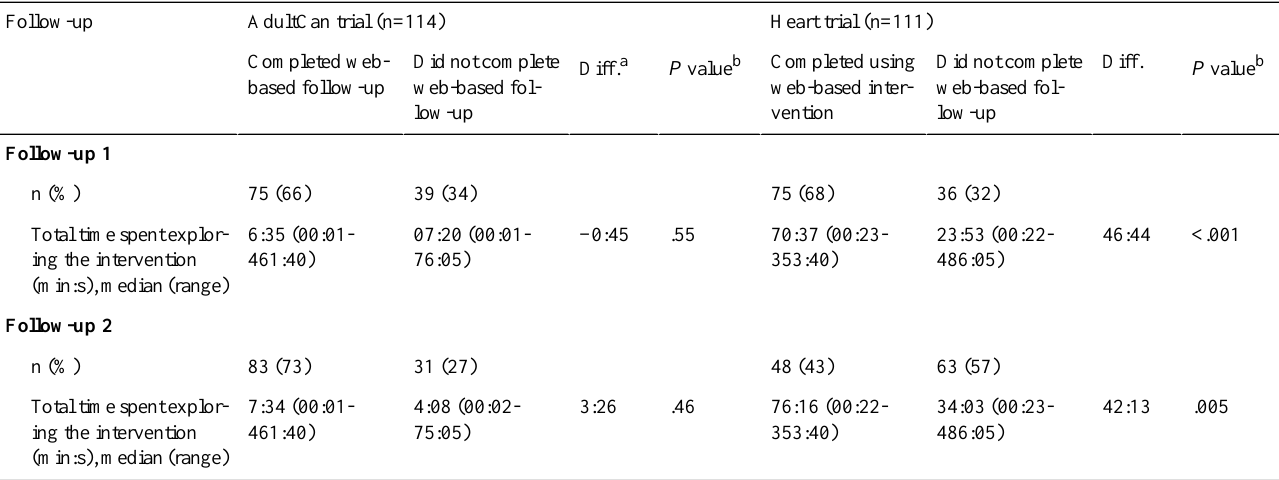
Table 6. Total time exploring the intervention during the first 14 days cross-tabled with completion of follow-up measures.